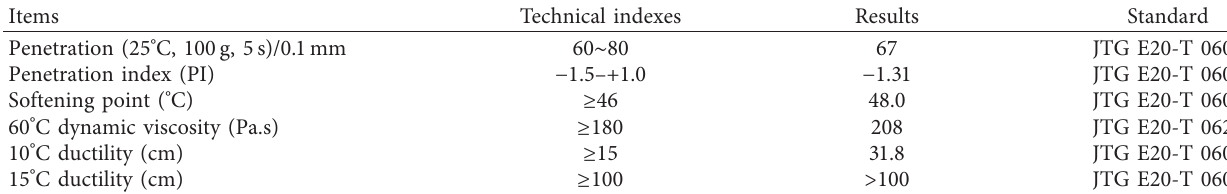
Table 1: Properties of the base asphalt.